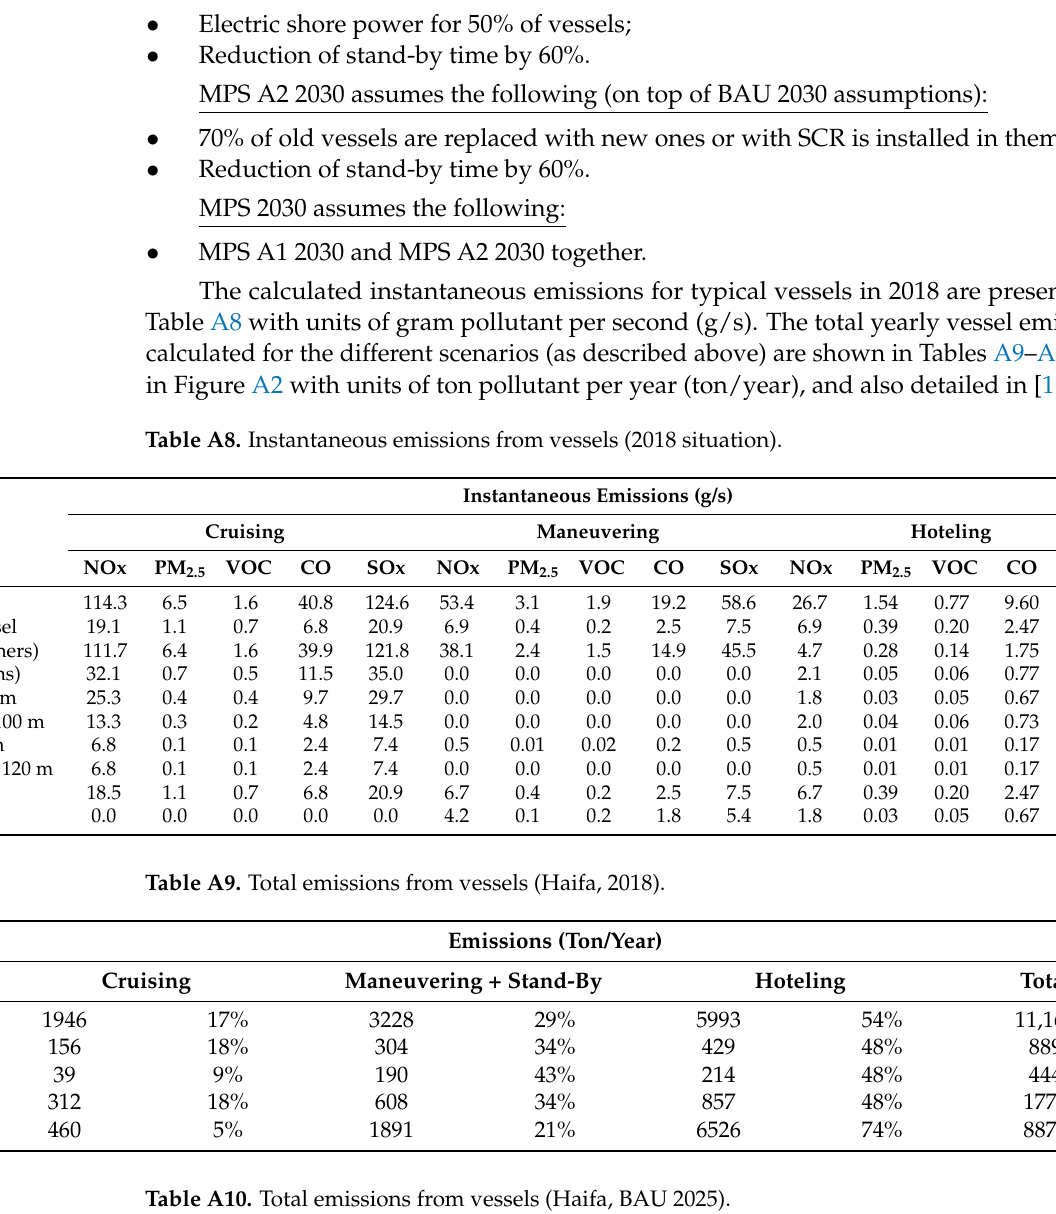
Table A10. Total emissions from vessels (Haifa, BAU